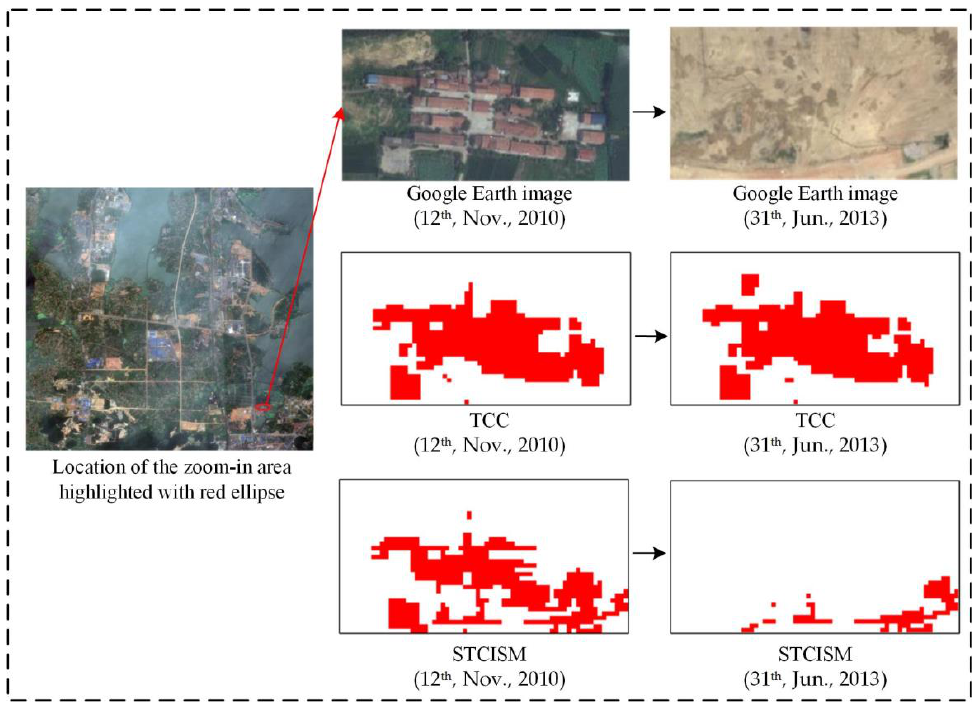
Figure 11. An example showing the difference between TCC (using unidirectional pervious-to-impervious surface conversion rule) and STCISM (using the bidirectional conversion rule between pervious and impervious surface) in mapping the impervious-to-pervious surface conversion. Red and white represent impervious and pervious surfaces, respectively.